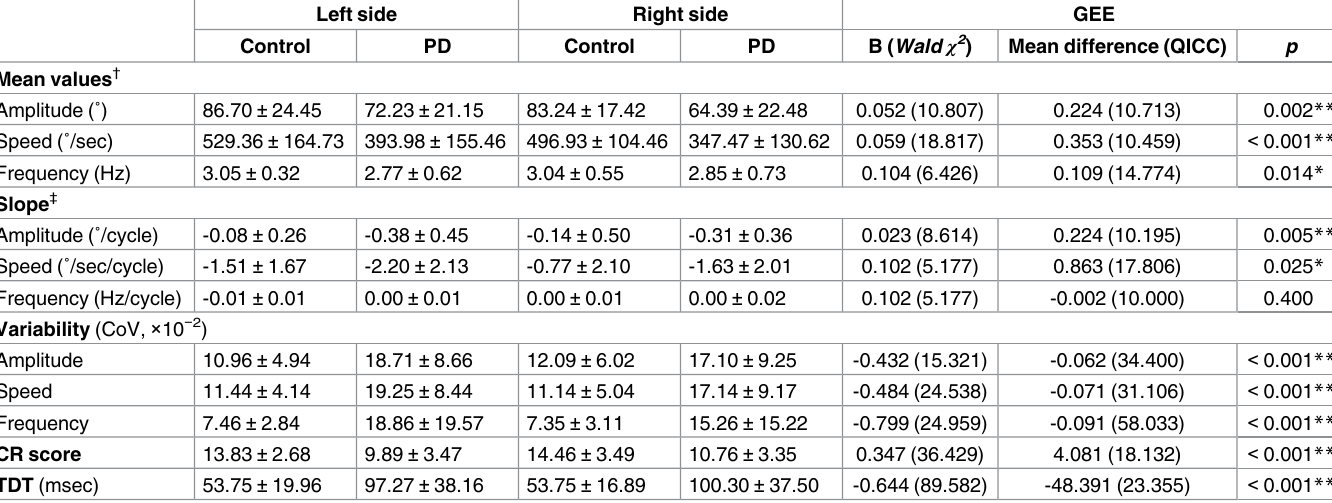
Table 1. Comparisons of kinematic parameters, coin rotation scores, and TDT values between PD and control groups. Left